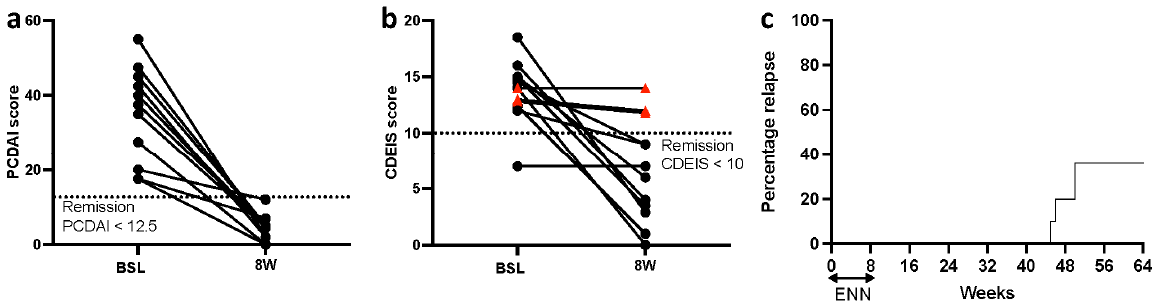
Figure 1. Pediatric CD patients achieved remission after ENN induction therapy. ( a ) PCDAI and ( b ) CDEIS scores at baseline and at week eight of EEN in 12 CD patients. ( c ) Kaplan–Meier survival curve showing time to relapse in 12 CD patients who remained in remission after EEN treatment. CD, Crohn’s disease; EEN, exclusive enteral nutrition; PCDAI, Pediatric Crohn’s Disease Activity Index; CDEIS, Crohn’s Disease Endoscopic Index of Severity.